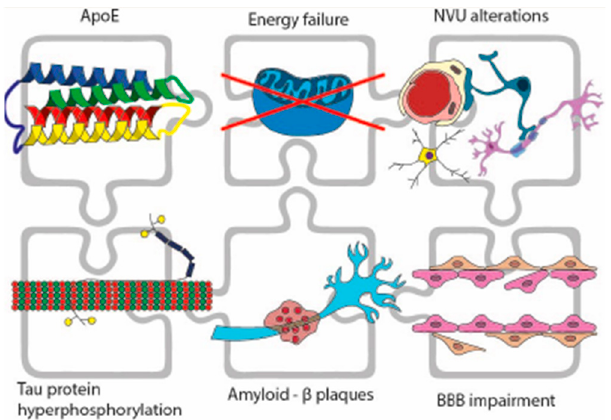
Figure 1. Genetic, metabolic, vascular, and energetic factors contribute to the onset and progression of Alzheimer’s disease. of Alzheimer’s